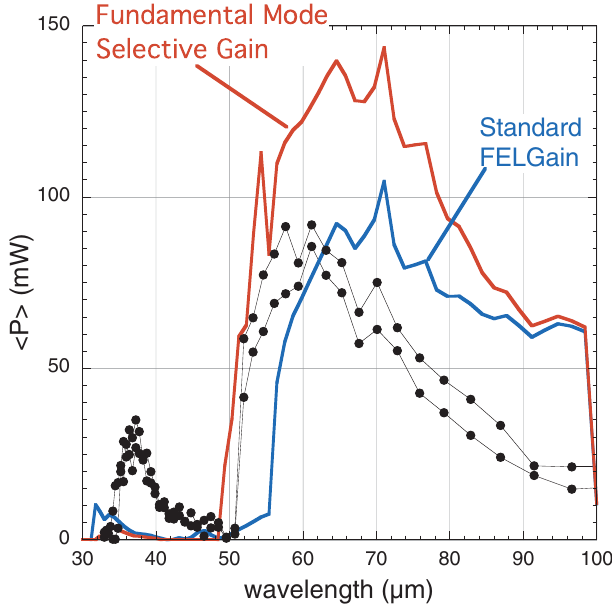
FIG. 3. (Color) Laser power vs centroid wavelength, for hybrid cavity: spherical for upstream and toroidal for downstream, using hole coupling of 3 mm. Bold lines are simulations.